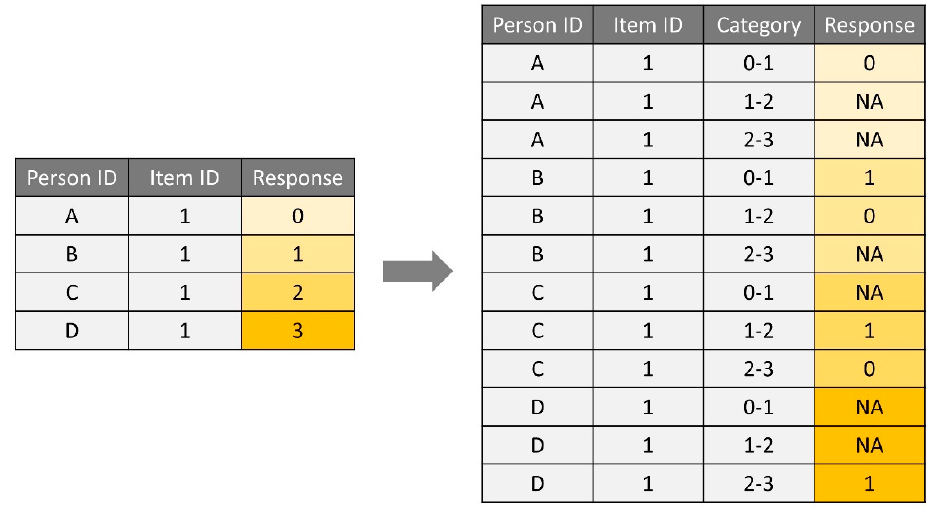
Figure 12. An example of how polytomous responses are defined as pseudo-dichotomous responses.